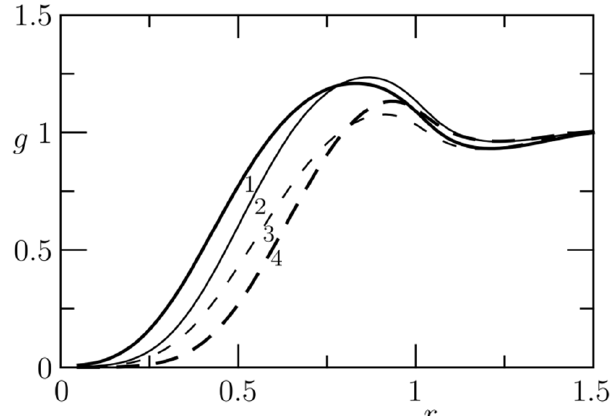
Figure 5. The radial distribution function, g ( r ), for the mixture of evenly and oppositely charged beads. The thick lines (1, 4) correspond to λ = 0.2, while the thin lines (2, 3) represent larger smearing with λ = 0.6. The full lines (1, 2) are radial distribution functions between particles bearing unlike charges, e + − , and the dashed lines (3, 4) are the radial distribution functions between particles with like charges, e ++ . Reproduced from Phys. Chem. Chem. Phys. 2016 , 18 , 16127 https://pubs.rsc.org/en/content/articlelanding/2016/cp/c6cp00341a, accessed on 15 December 2021 (supporting information) with permission from the PCCP Owner Societies.